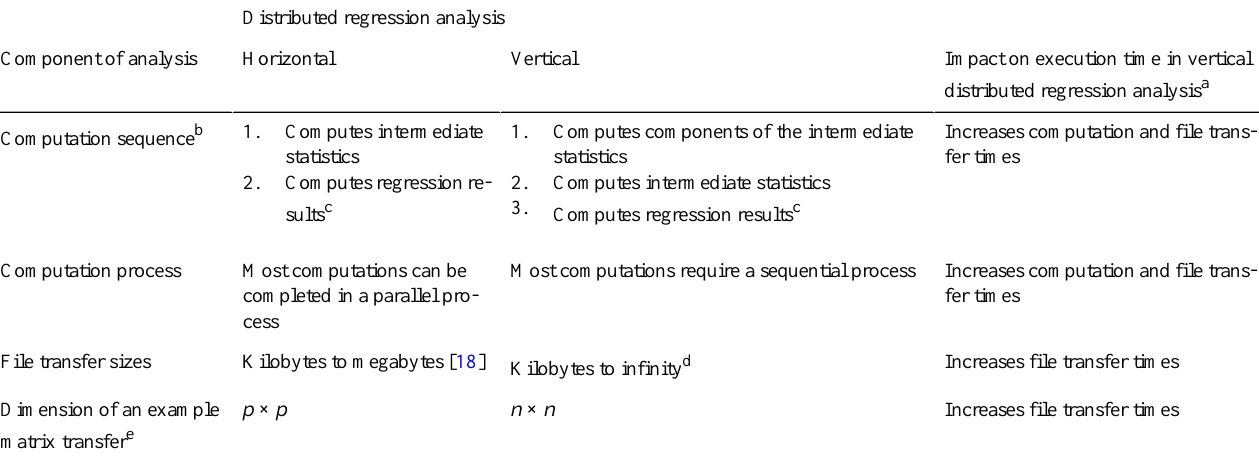
Table 1. Differences between horizontal and vertical distributed regression analysis and their impacts on execution